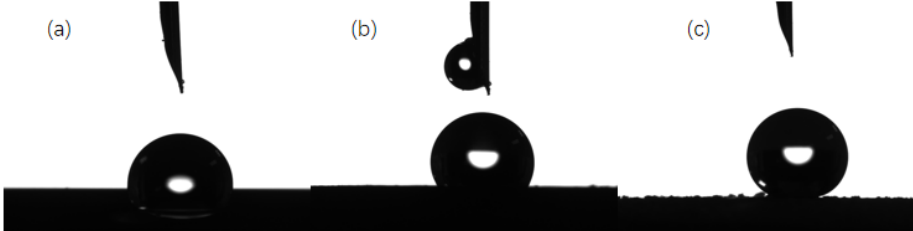
Figure 7. Water droplet shape on ( a ) insulator surface, ( b ) PDMS surface, and ( c ) FAS-17-modified nano-SiO 2 /PDMS surface.